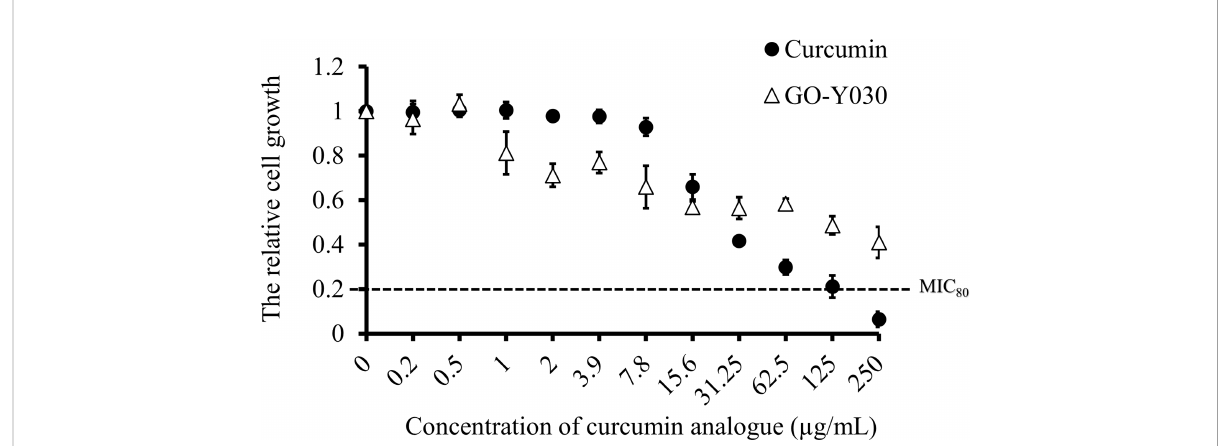
FIGURE 1 Curcumin compounds exhibit antifungal activity on C. albicans . Susceptibility assays of each curcumin analogue were conducted in YPD medium. Growth was measured by absorbance at 530 nm after 24-h incubation at 37°C. Optical densities were averaged for triplicate measurements and normalized relative to no antifungal compound control. Error bars represent standard deviation from the mean of triplicate